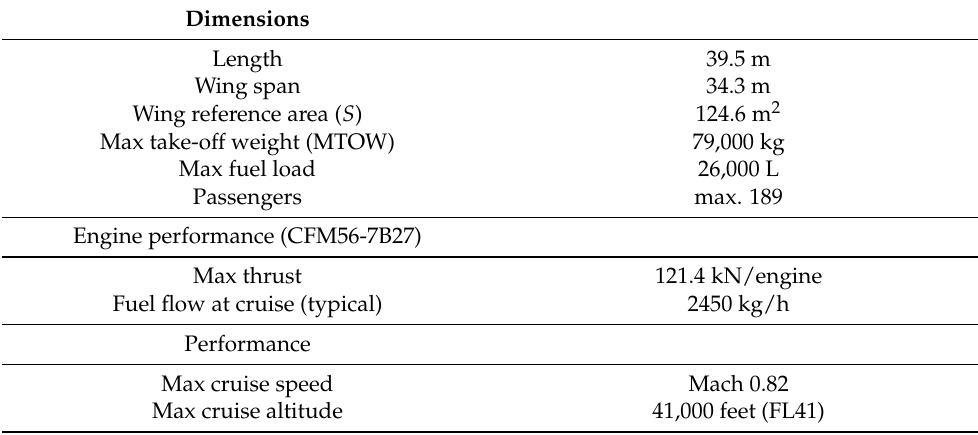
Table 1. Characteristics of the Boeing 737-800.